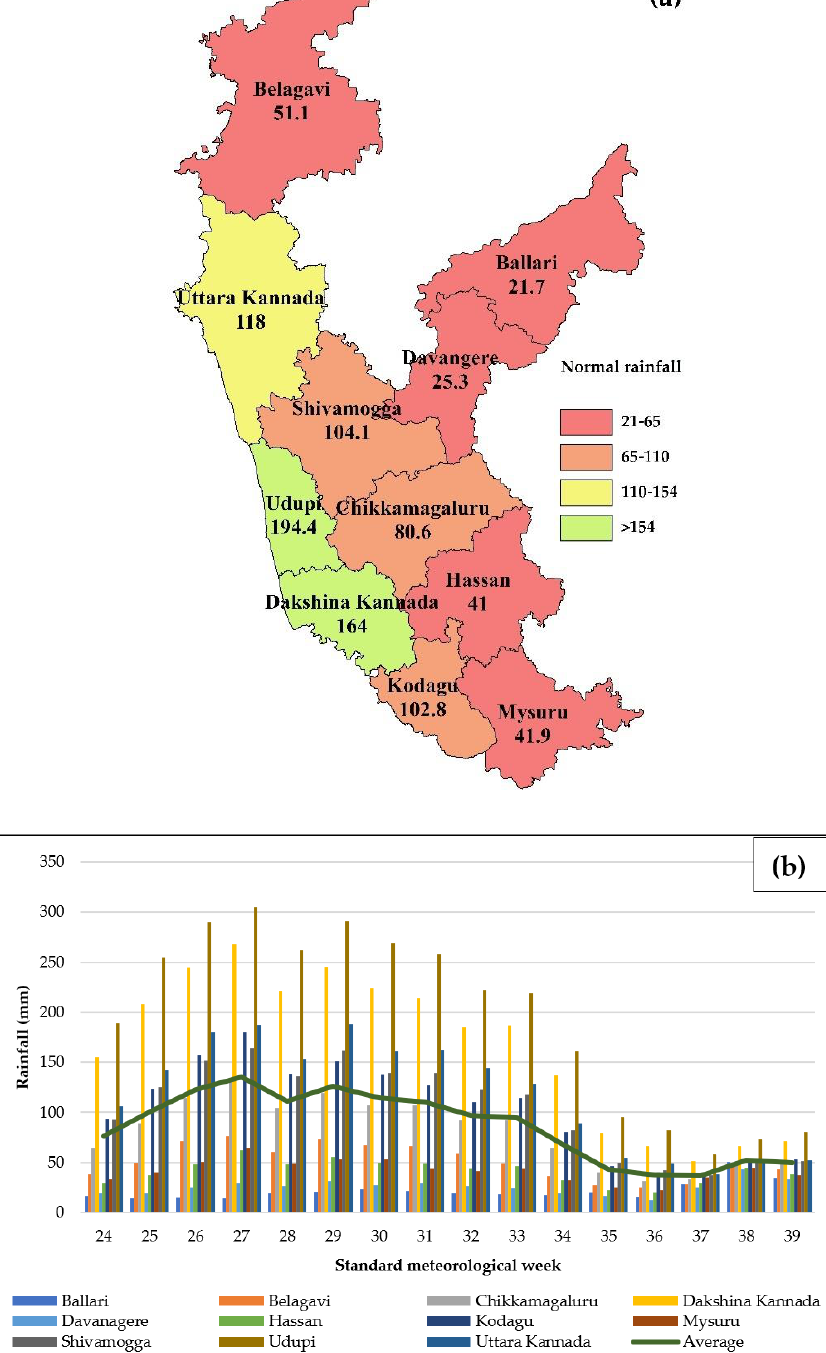
Figure 4. Spatial ( a ) and temporal ( b ) variability in rainfall in rice-growing districts during rice growing period, i.e., 24th to 39th